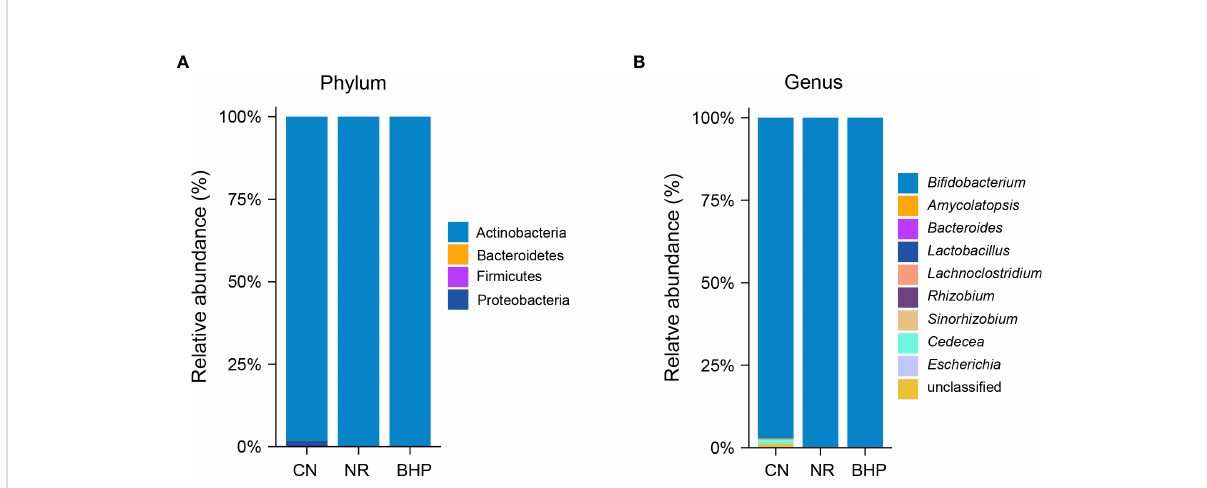
FIGURE 7 Taxonomic composition of the lactase-producing bacteria from the intestinal contents in each group. (A) Phylum level. (B) Genus level. CN, control group; NR, natural recovery group; BHP, Baohe pill decoction treatment